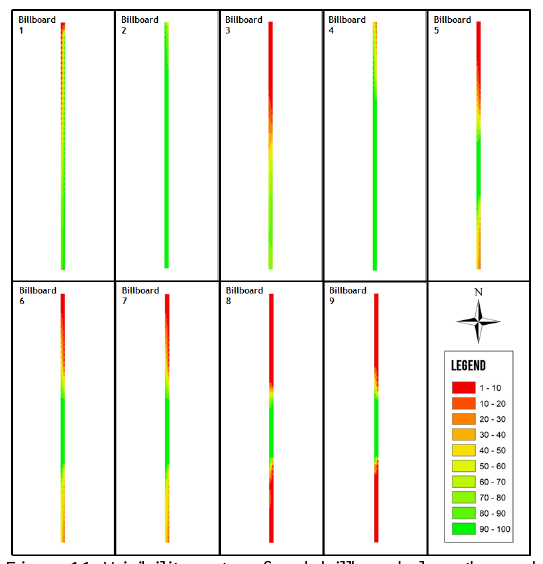
Figure 11. Visibility raster of each billboard along the road Shown above are the road visibility raster representations of the nine billboards, placed side by side for comparison. It can be seen that the nearer billboards, with respect to the road, are more visible, in general, than those billboards that are located farther, with respect to the road. Although, billboards 6, 7, 8 and 9 are bigger in size than billboards 1, 2, 3, and 4, they are placed at a more distant location; hence, they were blocked by the obstructions along the road – plants, bridge railings, and other nearer billboards.